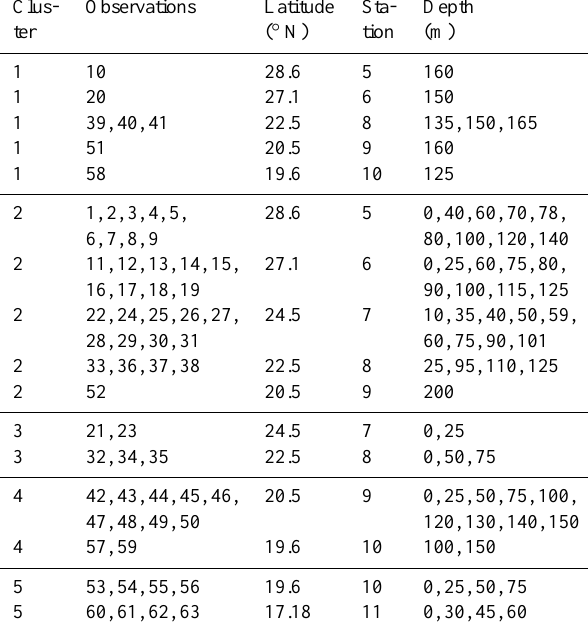
Table 1. List of observations between station 5 and 11 and their classifications into five clusters according to the PCA analysis.